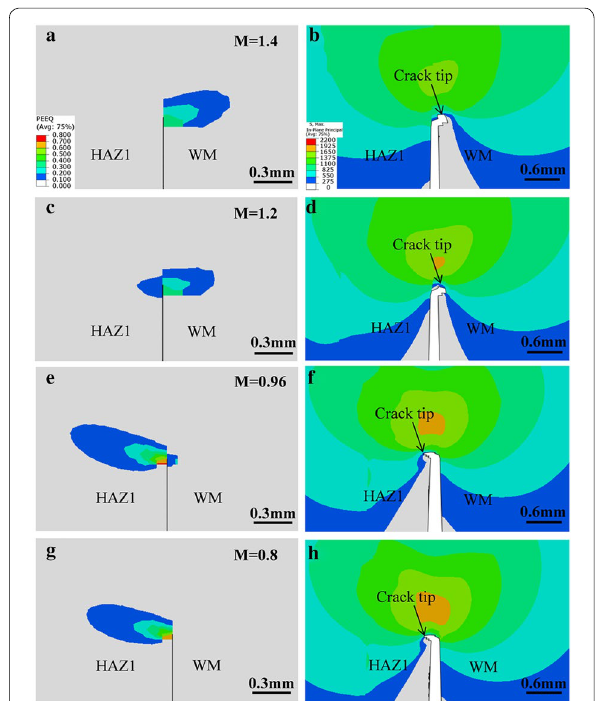
Figure 4 Distributions of strain and stress around crack tip at the interface between HAZ1/WM: a , c , e , g Equivalent plastic strain (PEEQ); (b)(d)(f)(h) Maximum principal stress ( S , max). (Unit in b , d , f , h is MPa)